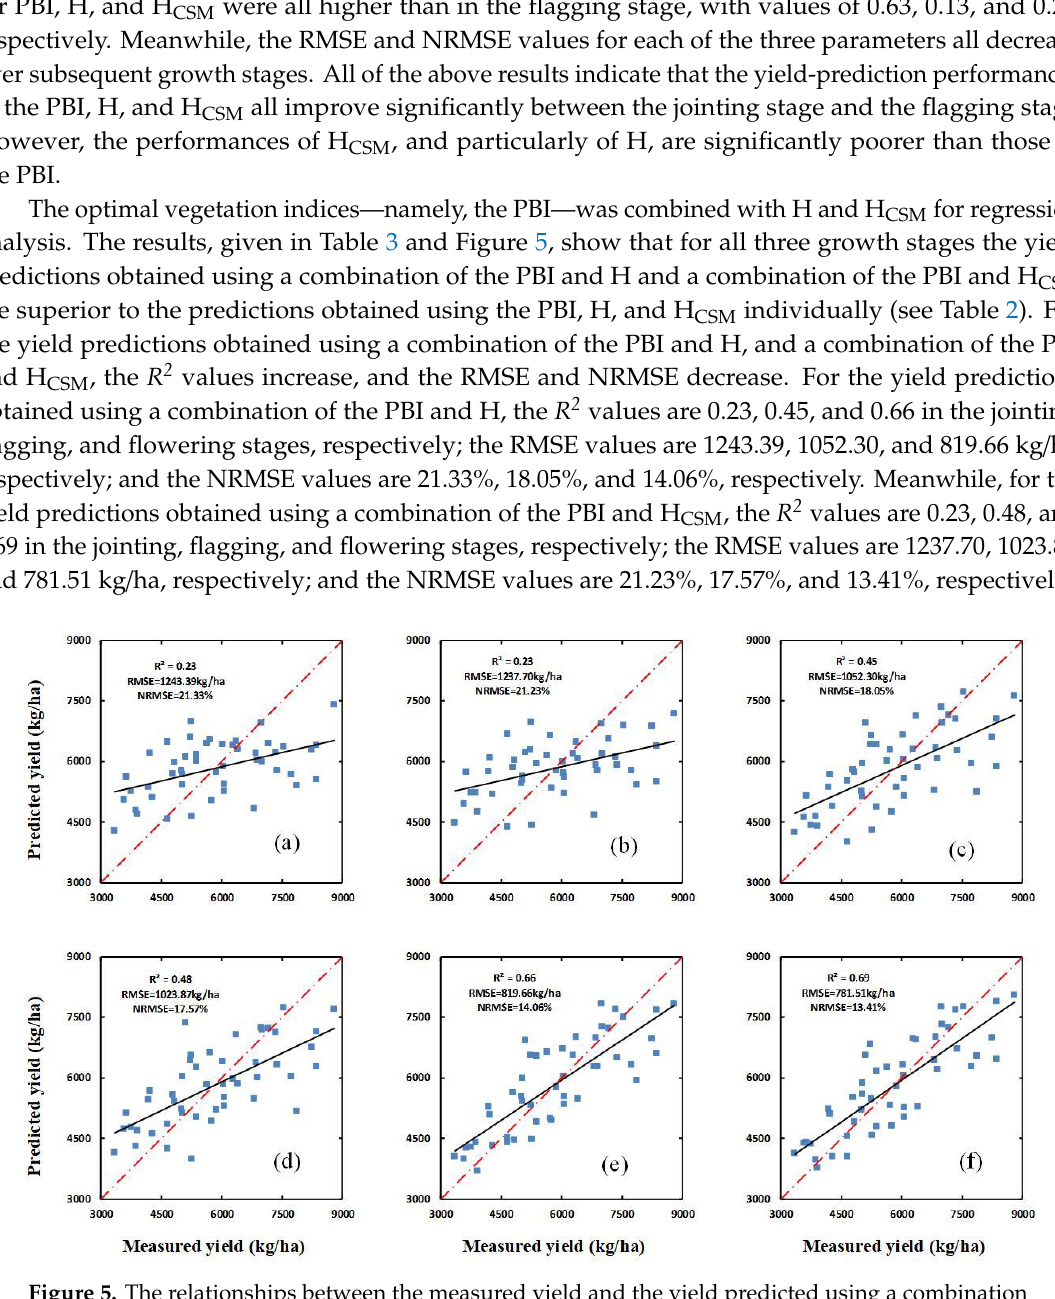
Figure 5. The relationships between the measured yield and the yield predicted using a combination of the PBI and H, and the yield predicted using a combination of the PBI and H CSM , at different growth stages ( a ) and ( b ) show the relationships between the measured yield and the yield predicted using a combination of the PBI and H, and using a combination of the PBI and H CSM , respectively, for the jointing stage; ( c ) and ( d ) show the same as ( a ) and ( b ) for the flagging stage, and ( e ) and ( f ) show the same as ( a ) and ( b ) for the flowering stage.